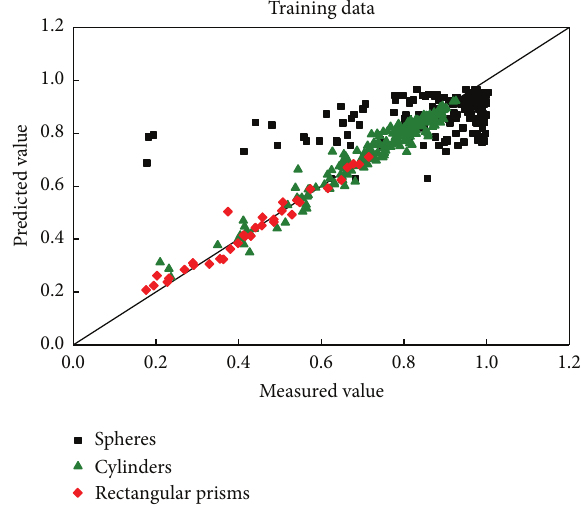
Figure 8: Comparison of the predicted and measured wall factors of all particles for the training